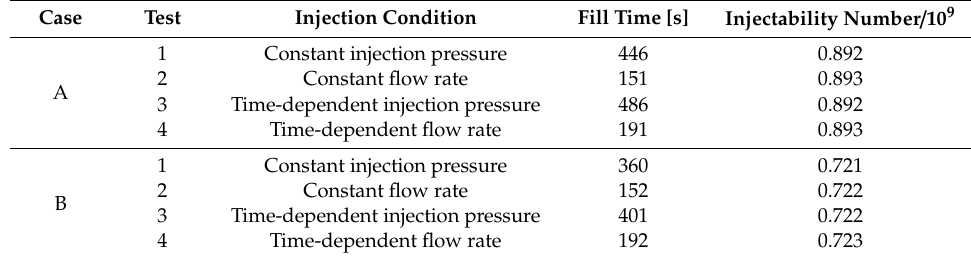
Figure 3. Selected cases of injection through a C-shaped inlet: case A ( top picture ) and case B ( bottom picture ). Table 3. Fill times and injectability numbers for injection cases through a C-shaped inlet.